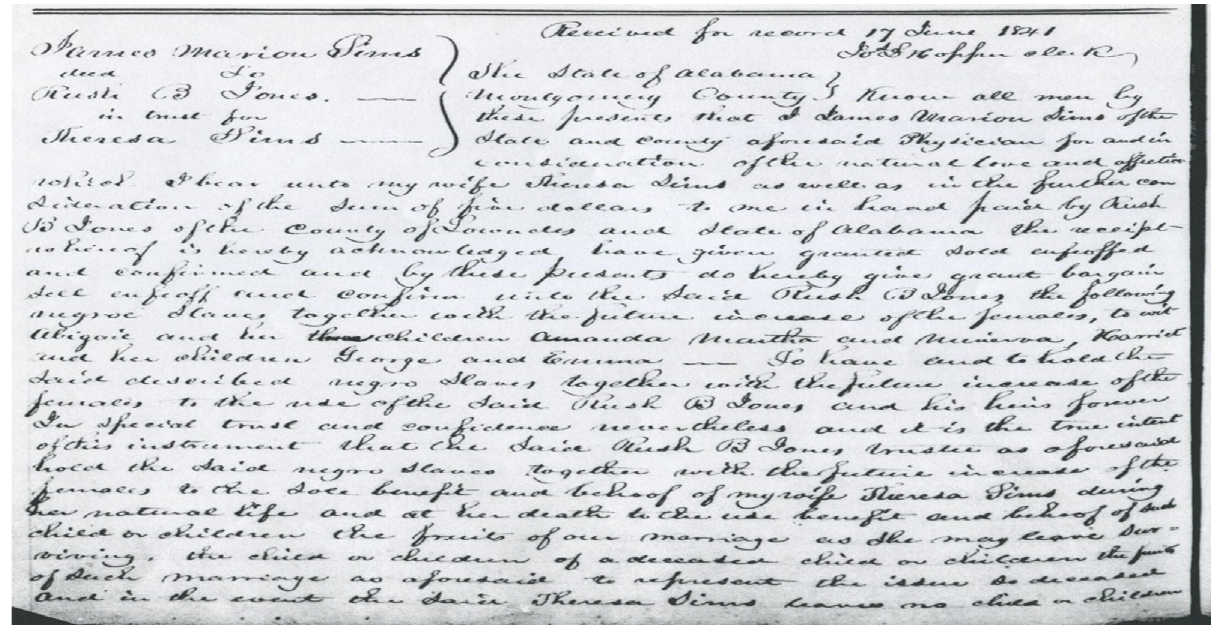
Figure 1. “James Marion Sims Property Deed to Rush B. Jones in trust for Theresa Sims” Montgomery, County 1841. Copyright of the Alabama Department of Archives and History.